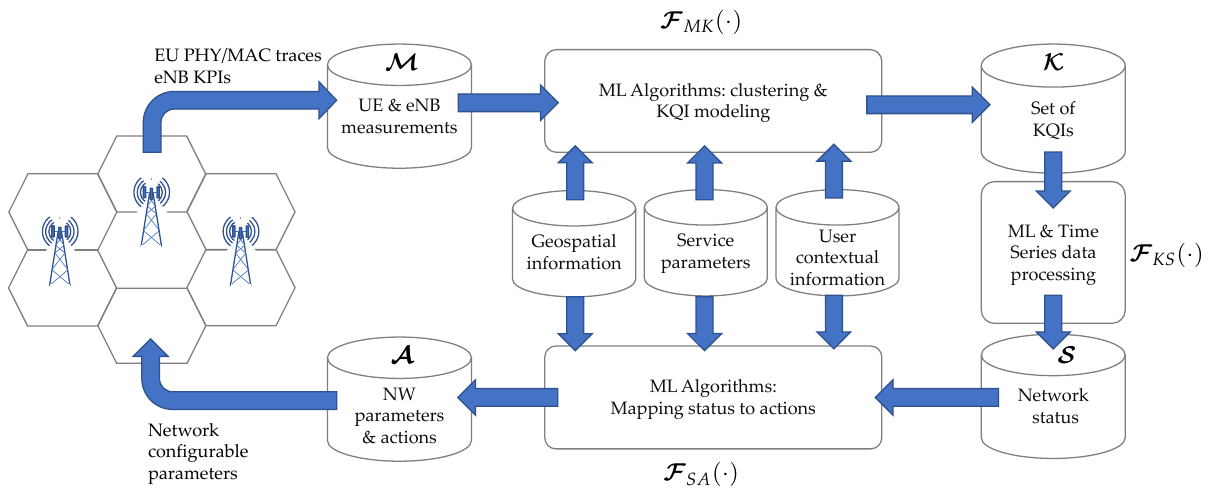
Figure 1. General information flow for SON status prediction and assessment through KQI modeling and processing.